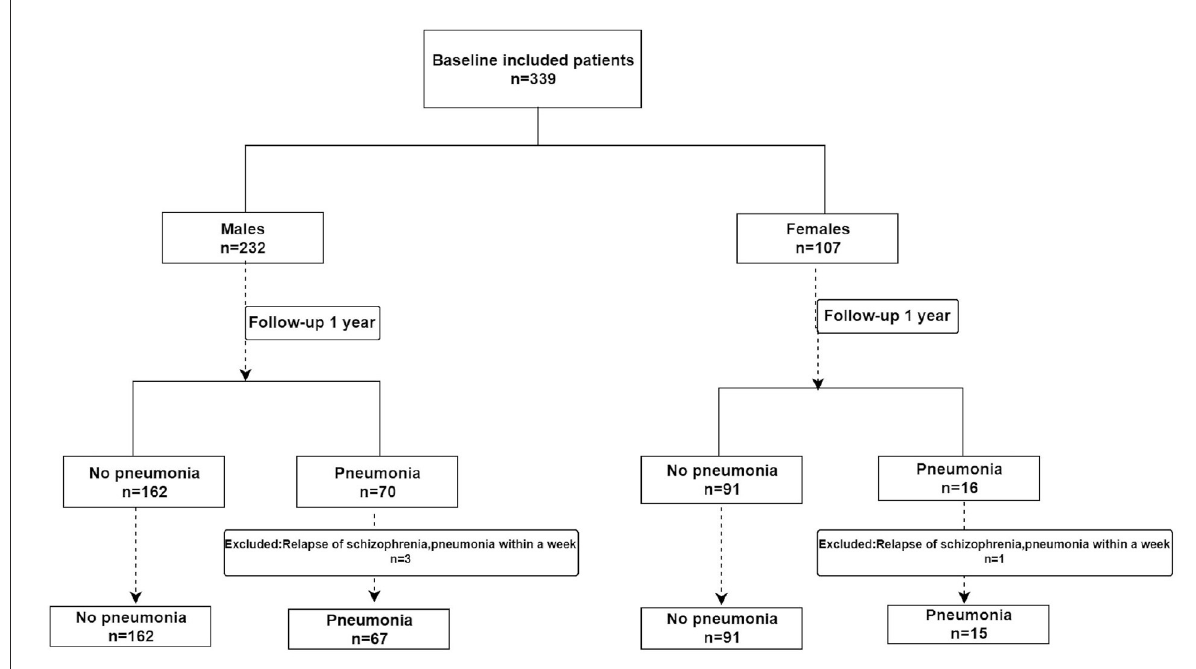
FIGURE1 The study profile included patient selection and pneumonia